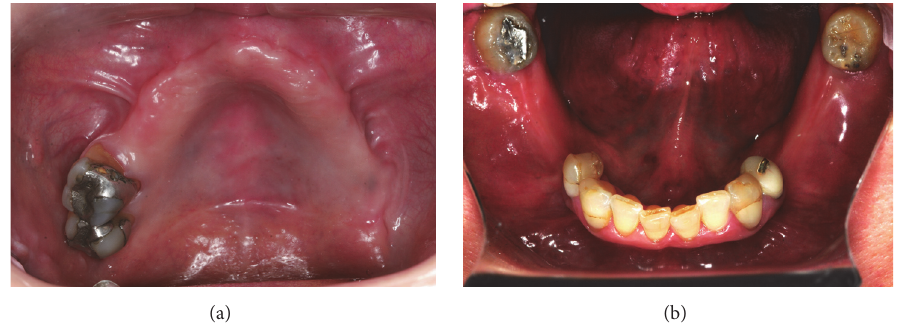
Figure 1: Clinical view at the initial appointment. Occlusal view of maxillary (a) and mandibular arch (b).